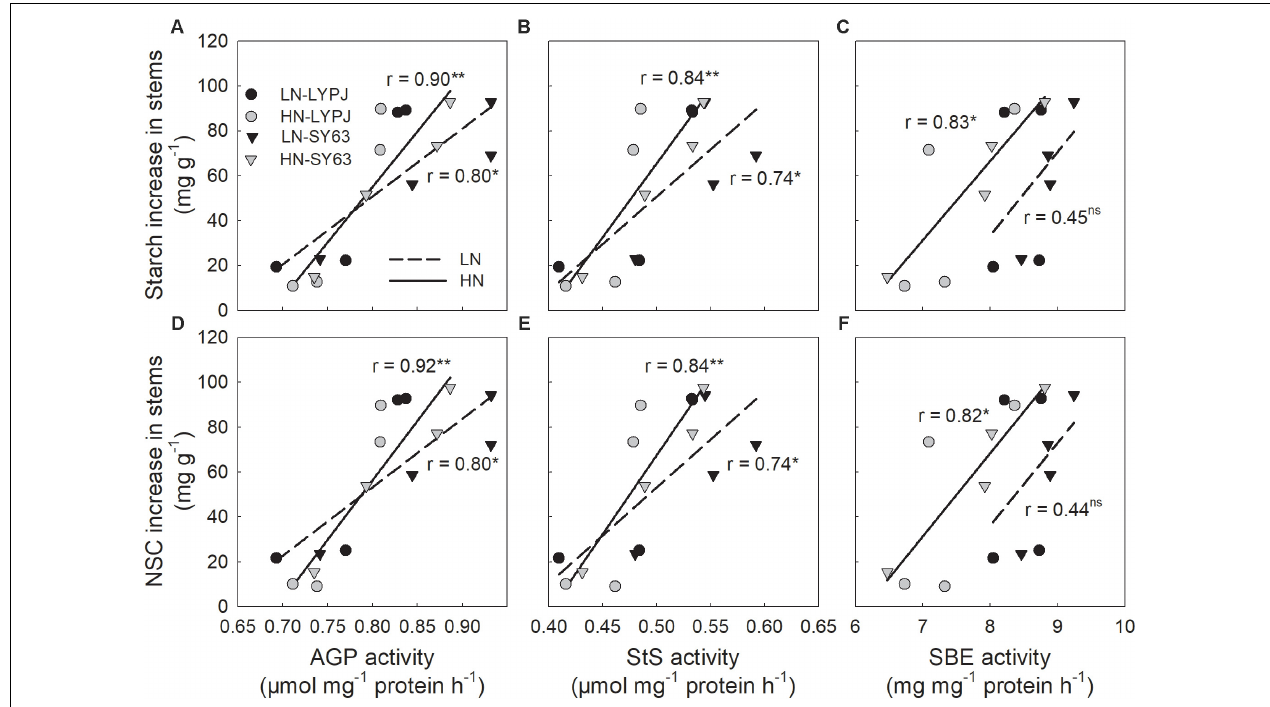
FIGURE 8 | Relationships between stem starch (A,B,C) and NSC (D,E,F) accumulation and the activities of AGP, StS, and SBE during the period of rapid starch accumulation (0–20 days after panicle initiation, n = 4 for each cultivar, n = 8 for each nitrogen treatment). ns, not significant at P < 0.05; ∗ and ∗∗ , significant at P < 0.05 and at P < 0.01,